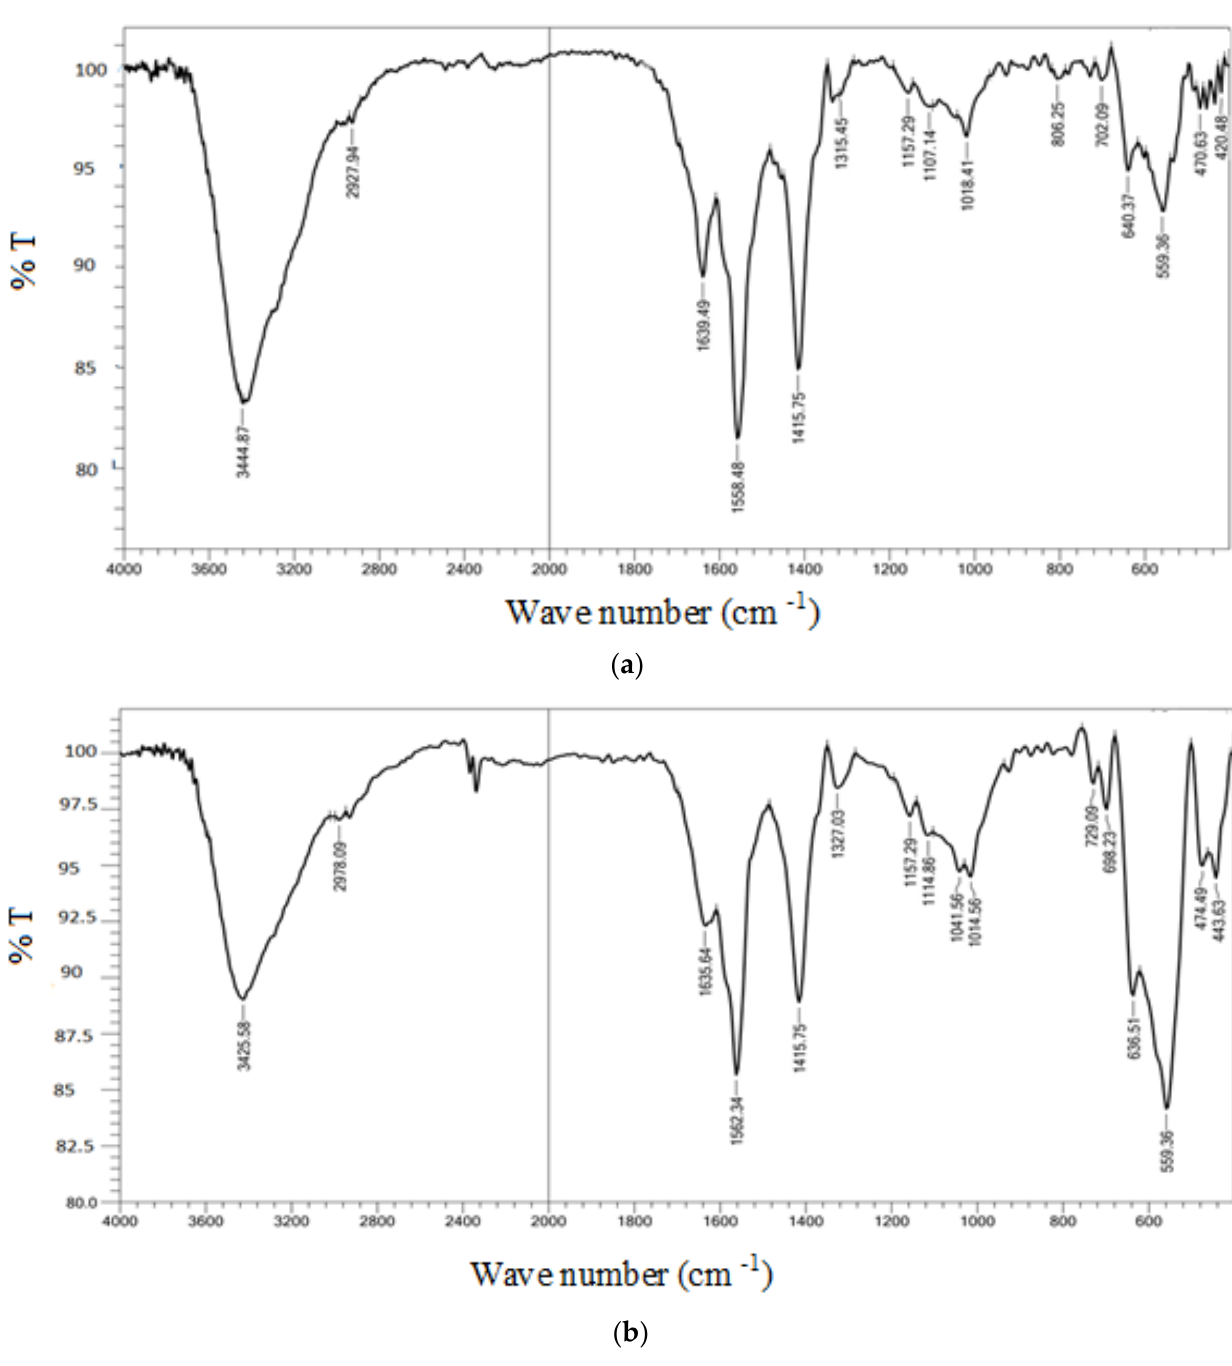
Figure 1. FTIR spectra of ( a ) Fe 3 O 4 /CA and ( b ) Fe 3 O 4 /CA after adsorption. The vibrating sample magnetometry (VSM) hysteresis loop magnetization curve was produced using a magnetometer at 298 °K. Figure 2 shows the magnetization curve of Fe 3 O 4 /CA, which confirms the superparamagnetic behavior. The resulting saturation mag- netization value of 24.5 emu/g is in agreement with the magnetic nanoparticle ’ s known values [32].